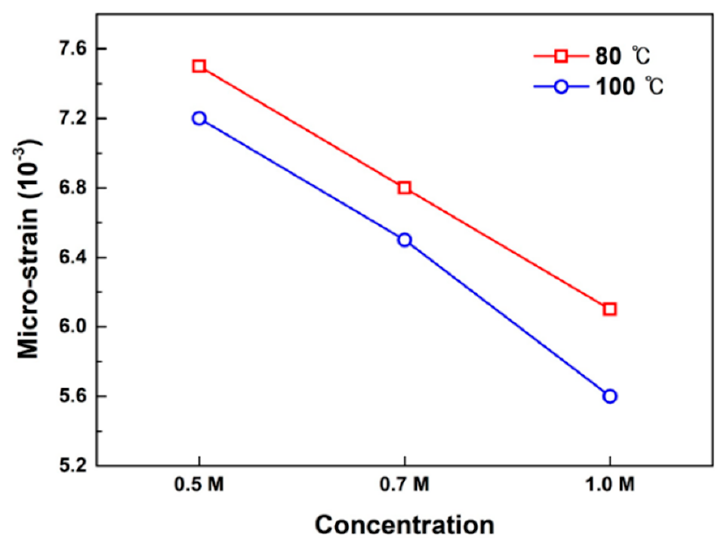
Figure 3. Strain of the β -Ga 2 O 3 films fabricated using solutions of different molar concentrations at drying temperatures of 80 and 100 °C.